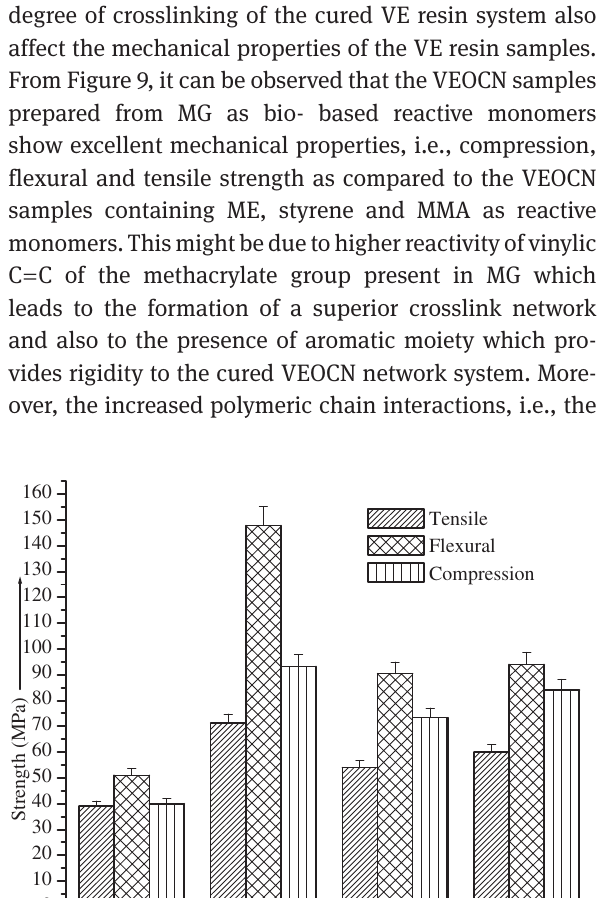
Figure 8: Comparative TGA scans for cured VE resin samples con- taining styrene, MMA, MG and ME as reactive monomers.